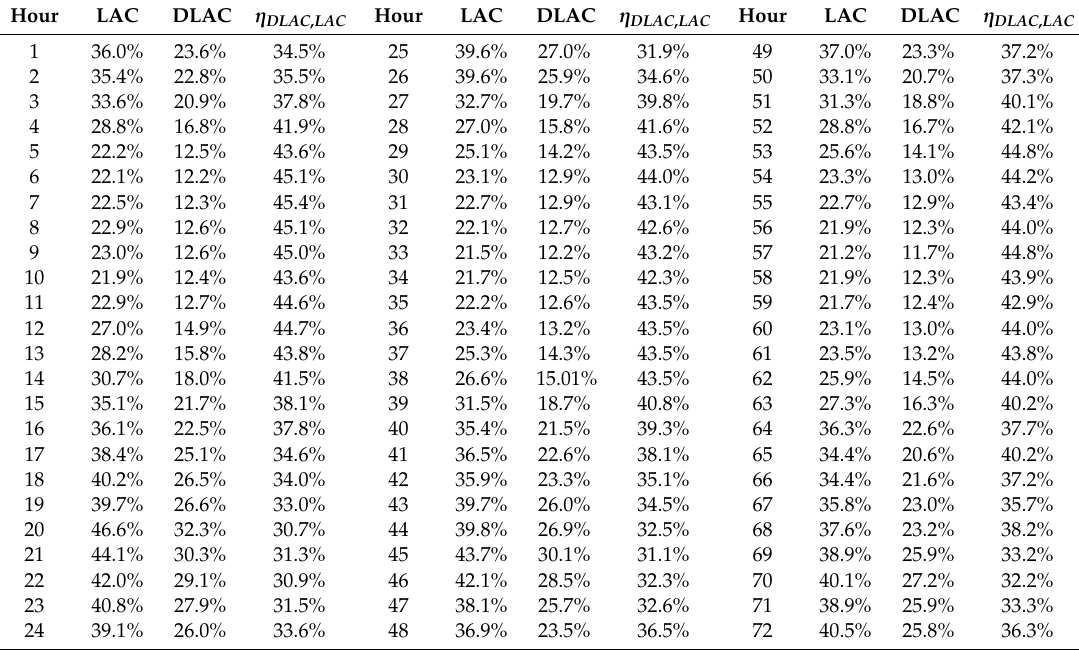
Table 15. Improvement of Reactive Power for Branches Exceeding 10 MVAr for 72 Consecutive